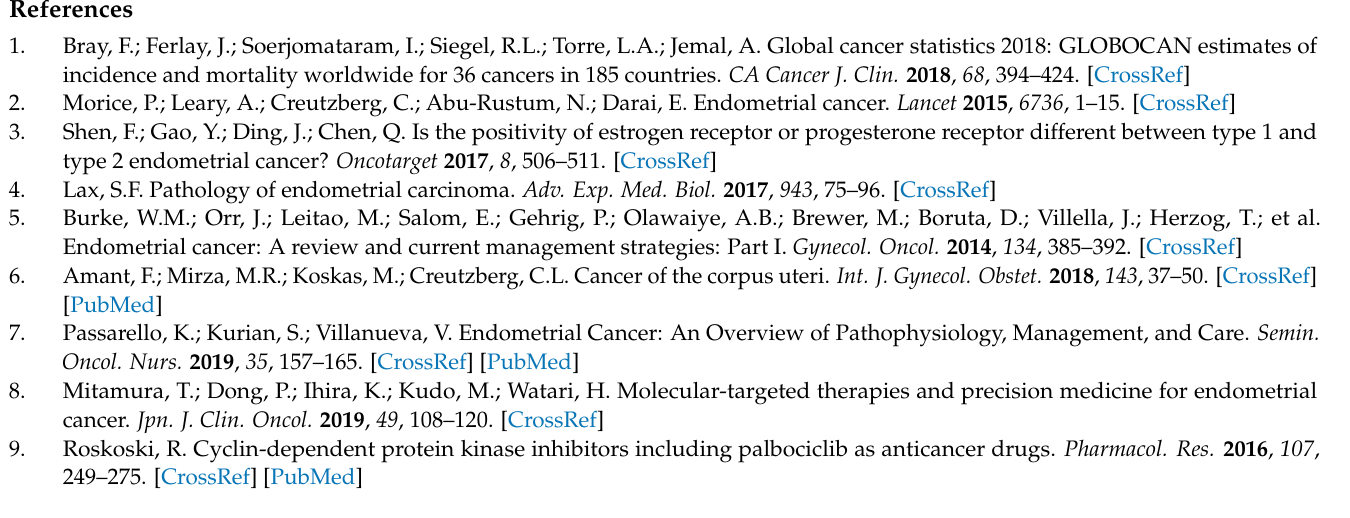
IHC data, Figure S1: Apoptosis in EC cell lines, Figure S2: MPM2 levels, Figure S3: Staurosporine in EC cell